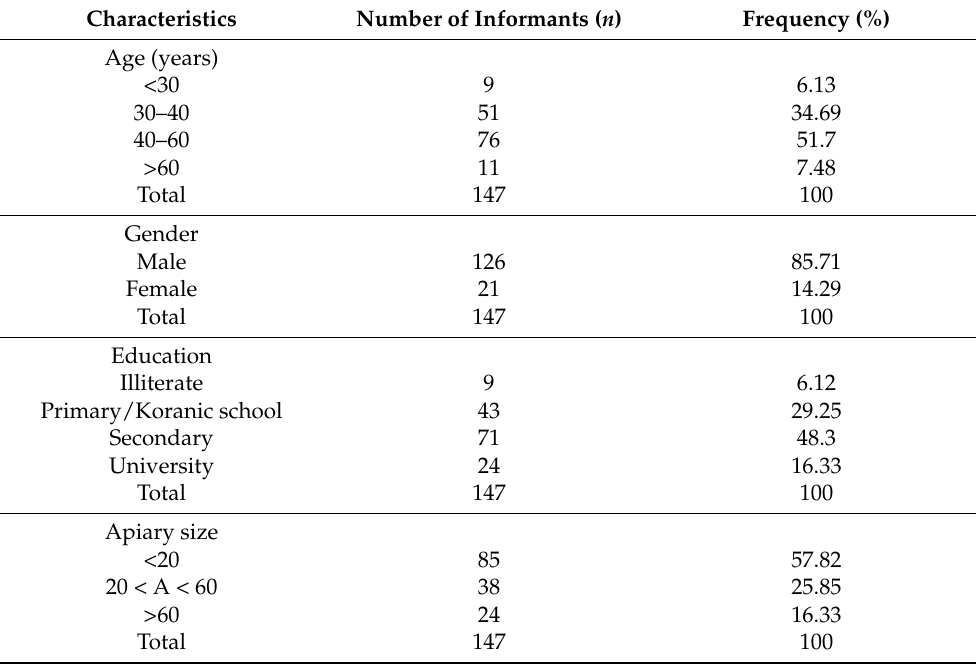
Table 3. Sociodemographic characteristics and experience of